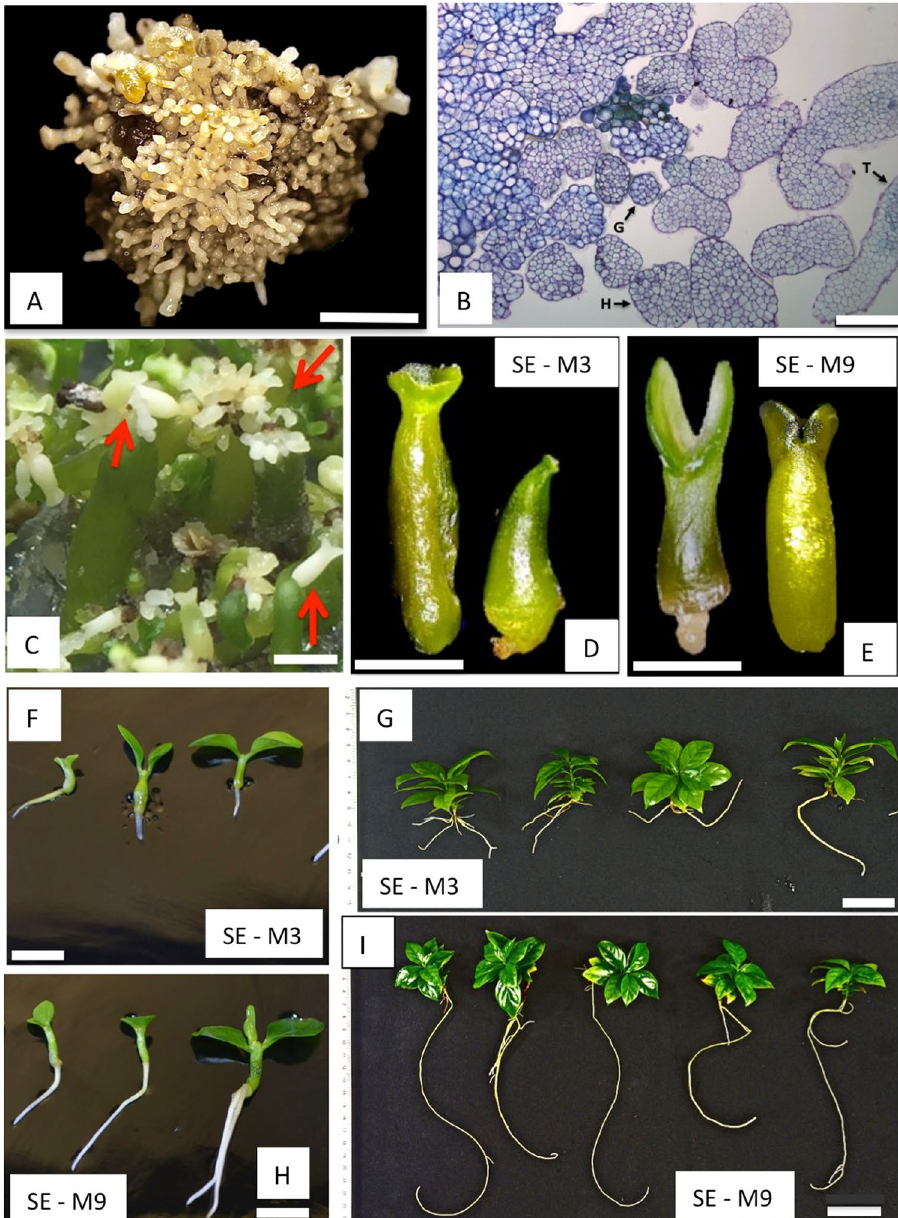
Figure 1. SEs maturation of coffee C. arabica var. Typica. ( A ) PEM of C. arabica var. Typica at globular and early torpedo stage with high competence of genetic transformation. PEM containing 200 SEs were used to initiate SEs maturation. Bar represents 2 mm. ( B ) Histological analysis of clusters of SEs at globular and early torpedo stage. Bar represents 100 μm. ( C ) First stage of SEs maturation after one month of culture. Secondary SEs were developed at this stage. Bar represents 5 mm. Red arrows indicate secondary SEs. ( D ) SEs at the end of second stage of maturation in SE-M3 non-osmotic medium after one month of culture. Bar represents 2 mm. ( E ) SEs at the end of the second stage of SEs maturation in SE-M9 osmotic medium after one month of culture. Suspensor-like structures at the base of SEs are present. Cotyledons are well developed. Bar represents 1.5 mm. ( F ) Plantlet conversion of SEs developed from SE-M3 non-osmotic medium cultured in SE-G medium after 30, 45 and 60 days from left to right, respectively. Bar represents 5 mm. ( G ) Regenerated plants after 5 months in SE-G, derived from SE-M3 non-osmotic medium. Small root 3.7 cm length and 8 leaves can be appreciated in these plants. Bar represents 3 cm. ( H ) Plantlet conversion of SEs developed from SE-M9 osmotic medium cultured in SE-G medium after 30, 45 and 60 days from left to right, respectively. Bar represents 5 mm. ( I ) Regenerated plants after 5 months in SE-G, derived from SE-M9 osmotic medium. Long pivotal root about 27.6 cm of length and 12 leaves can be appreciated in these plants. Bar represents 3